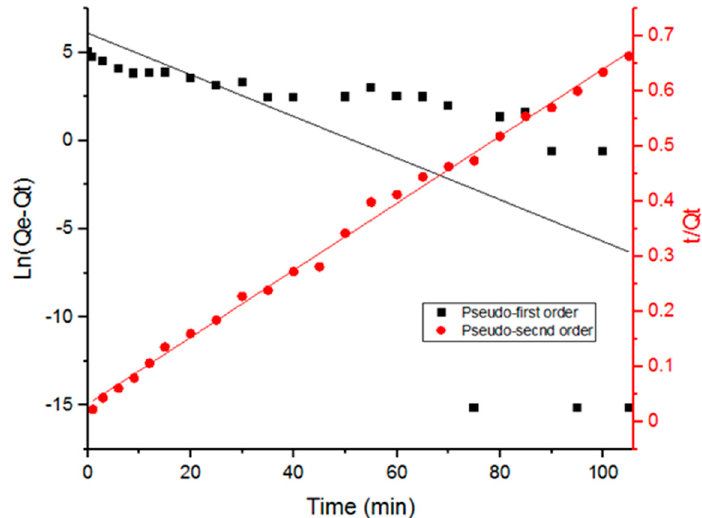
Figure 5. Fitting data with pseudo-first and pseudo-second order kinetics of Doxycycline adsorption onto UiO-66 .